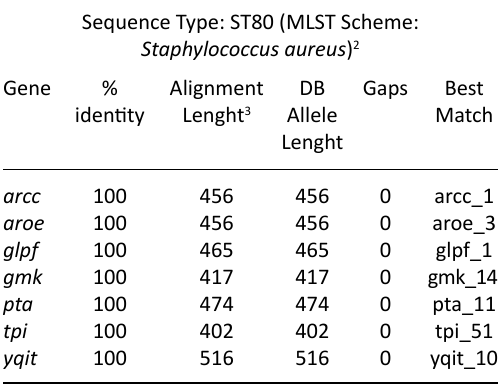
Table 2. Whole genome sequencing results showing MLST type 80